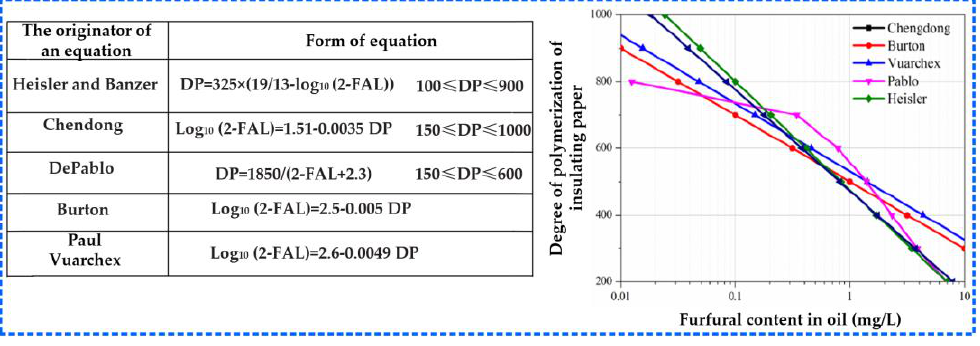
Figure 6. Relationships between furfural content in oil and DP of insulating paper.